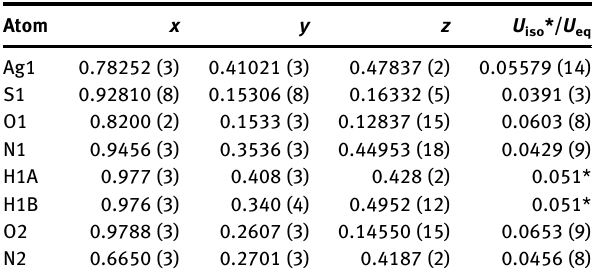
Table  : Fractional atomic coordinates and isotropic or